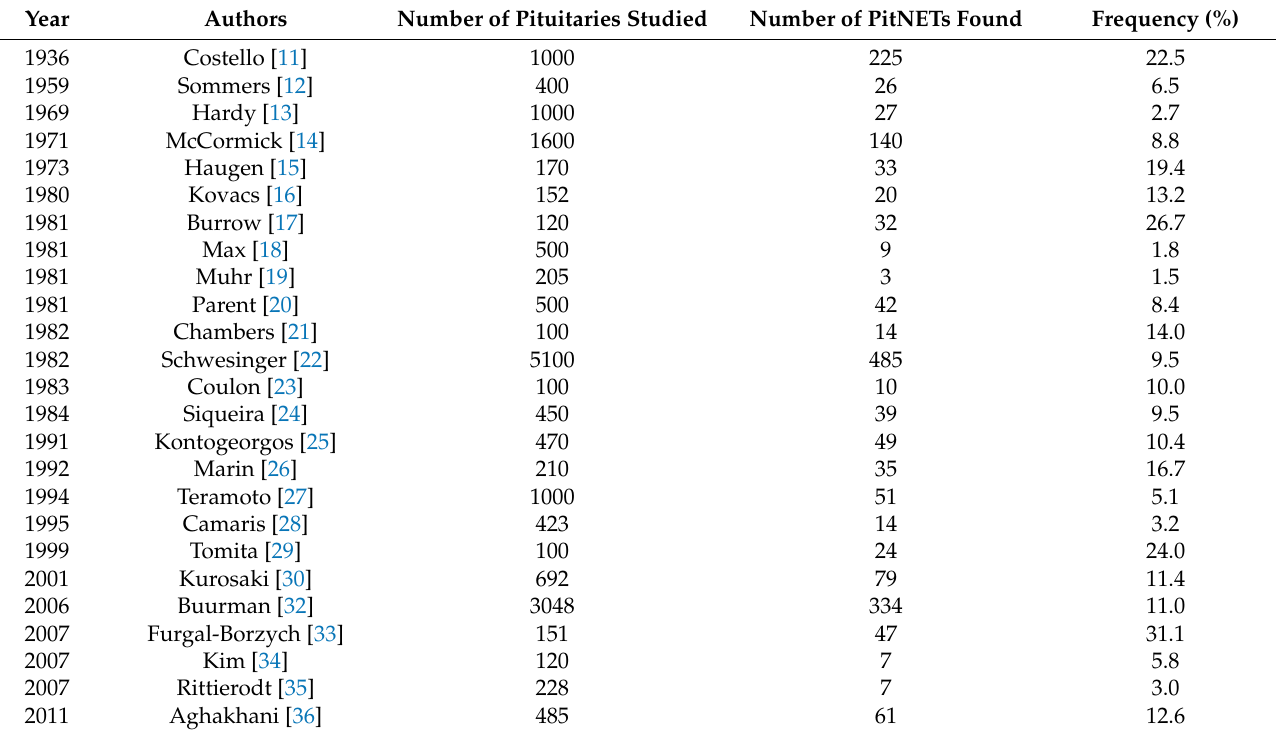
Table 1. Frequency of PitNETs found at